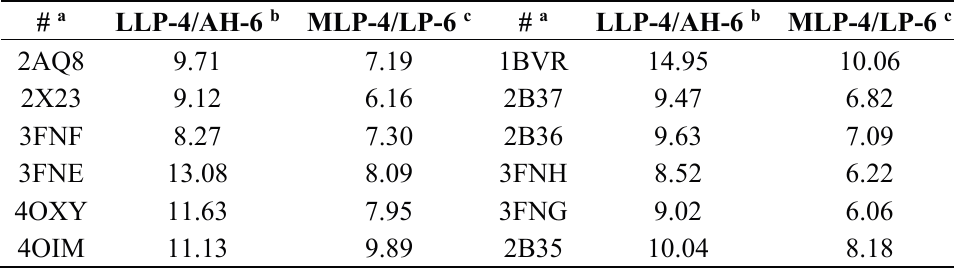
Table 2. LLP-4/AH-6 and MLP-4/LP-6 interatomic distances evaluated in all complexes to characterize the open and closed states of the InhA